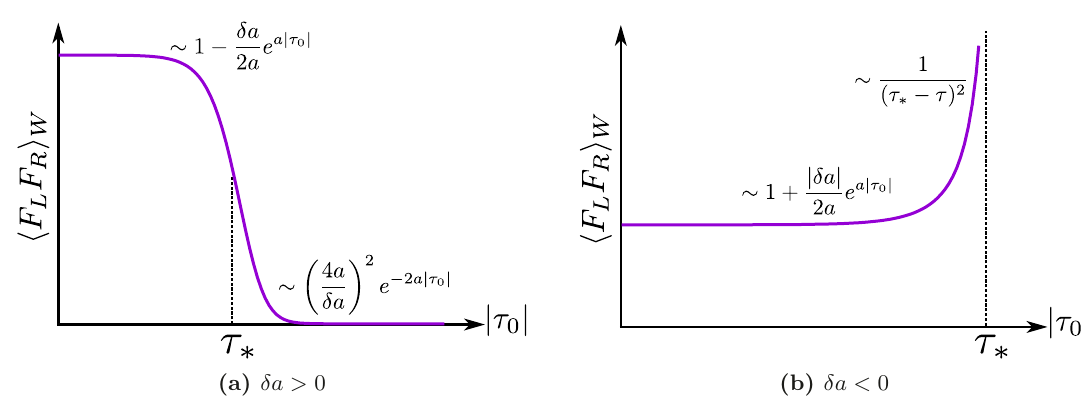
Figure 5. Correlation function for δa > 0 and δa <